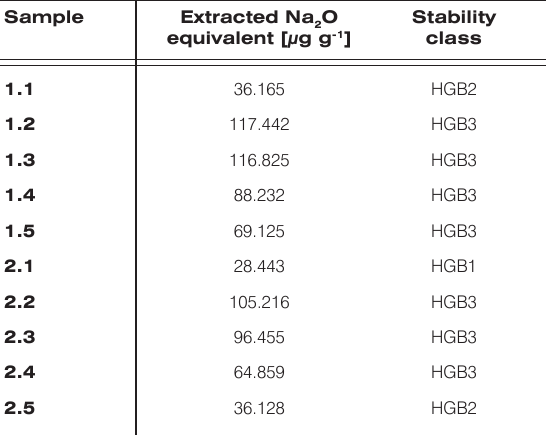
Table 3. The hydrolytic stability and the corresponding stability class of the investigated glass foams.